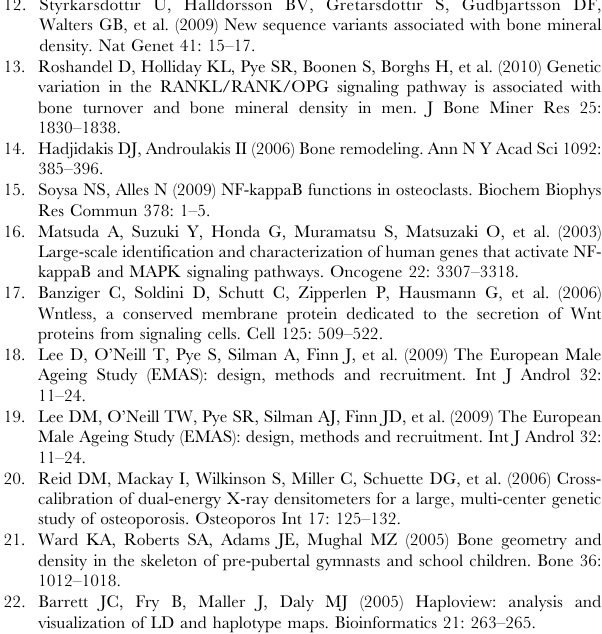
Figure 2. The decline in lumbar spine areal BMD by increasing number of carried risk alleles of rs9594738 ( RANKL ) and rs8065345 ( MAP3K14 ).